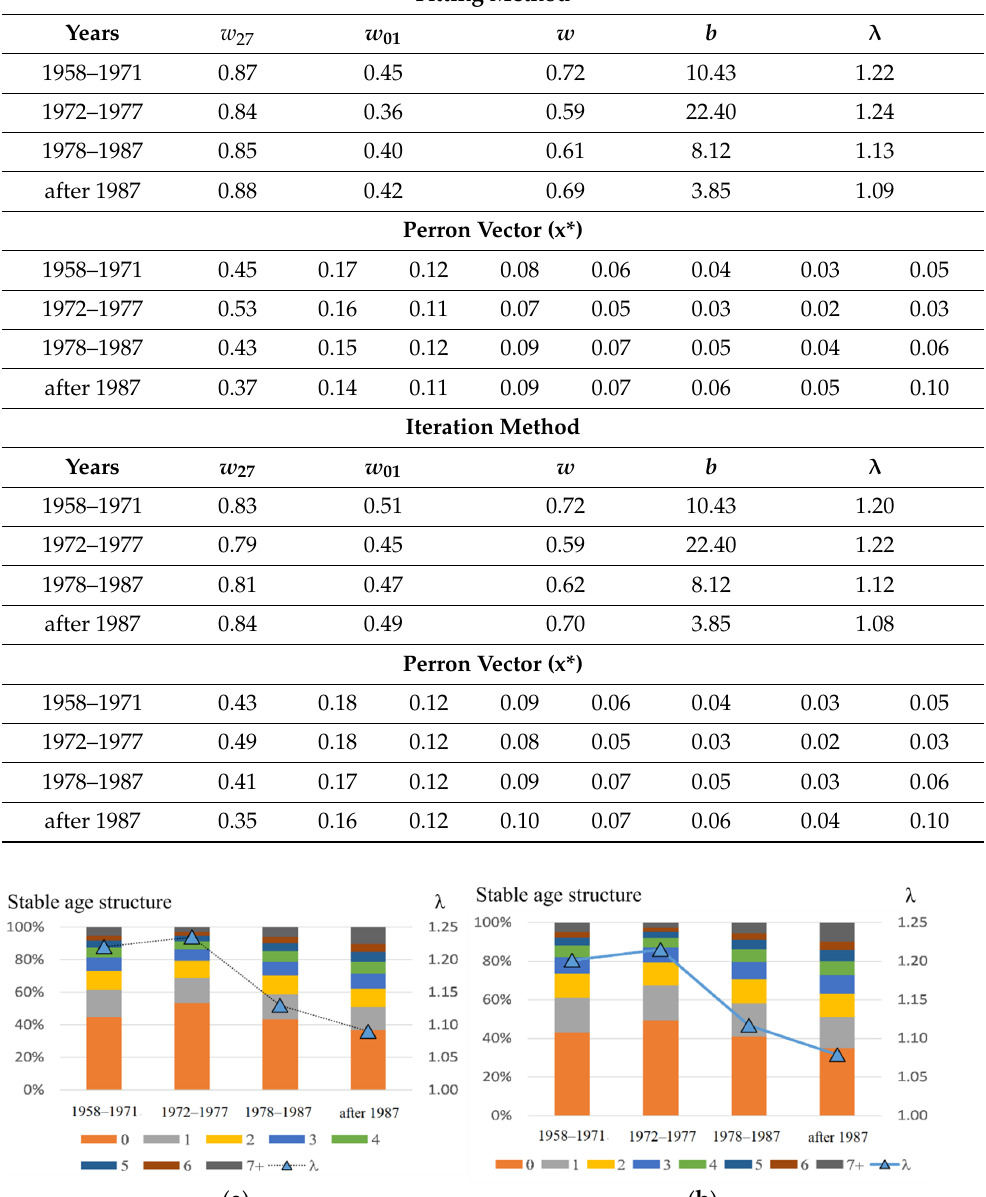
Table 1. Model coefficient values (adapted from [25]), annual growth rate of the population ( λ ) and its stable age structure (x*).